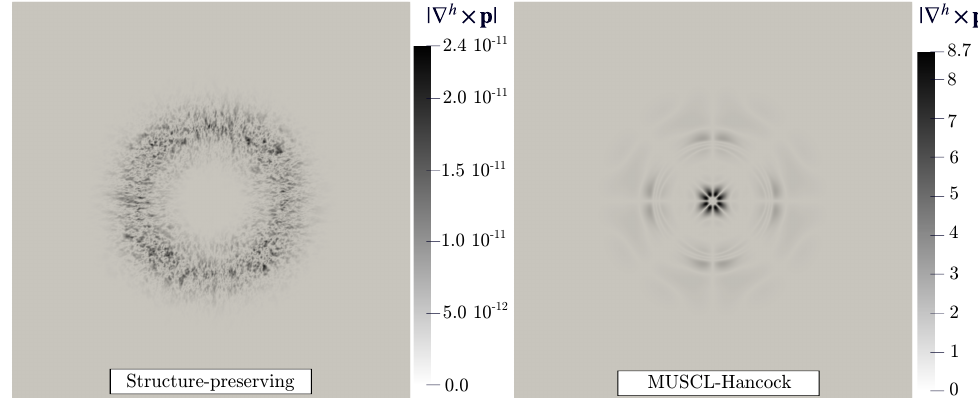
h over the full computational p |∇ × | 512 ×